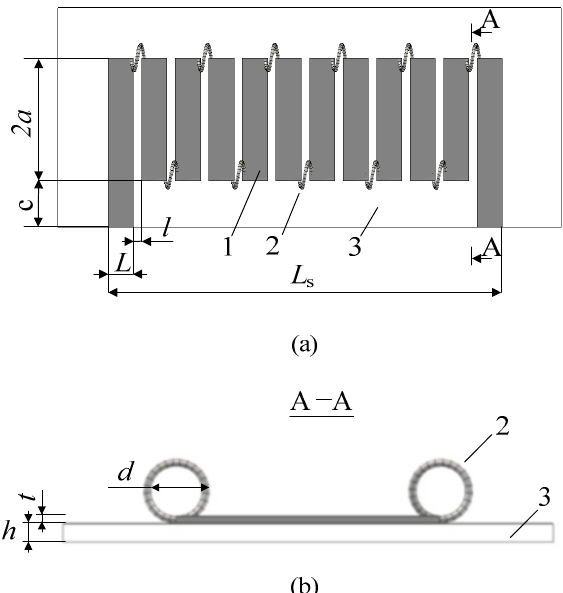
Figure 2. ( a ) Top view of hybrid meander conductor, and ( b ) Cross-view of hybrid meander conductor, where 1 = central meander electrode; 2 = peripheral helical turns of electrode; and 3 = dielectric substrate.